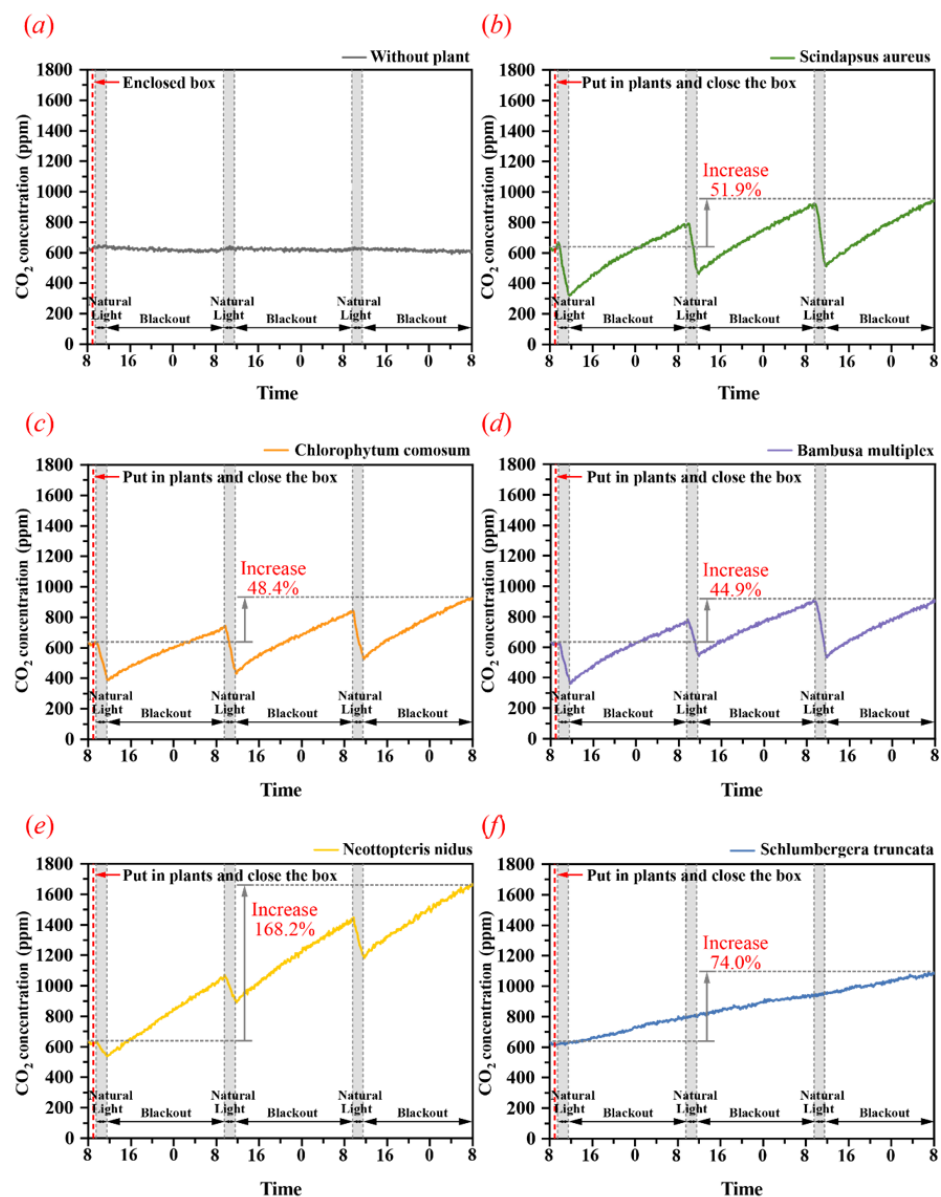
Figure 4. Fluctuation of CO 2 concentration in six sealed chambers in the poor lighting environment. ( a ) without plant ( b ) Scindapsus aureus ( c ) Chlorophytum comosum ( d ) Bambusa multiplex ( e ) Neottopteris nidus and ( f ) Schlumbergera truncate . Table 3. Comparison of CO 2 concentration in sealed chambers in the poor lighting environment.